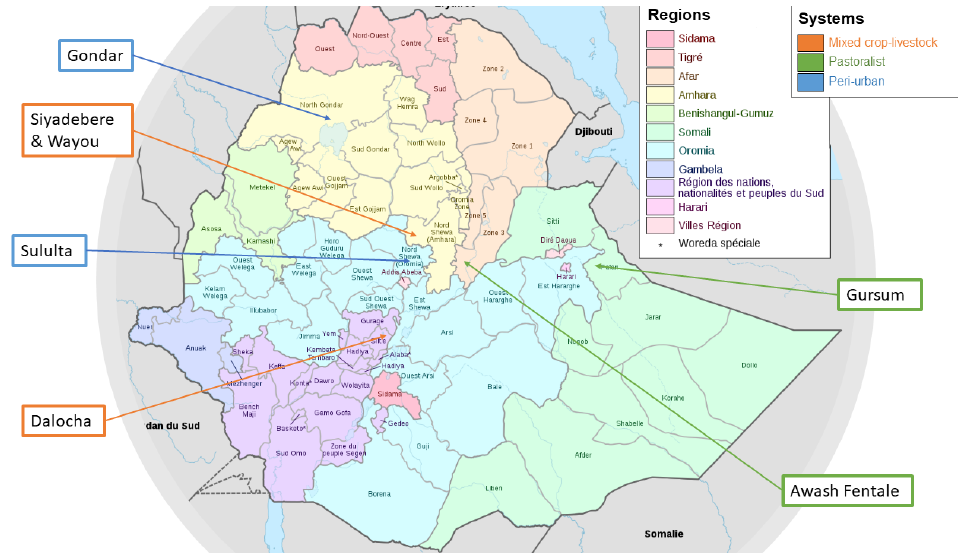
Figure 1. Map of Ethiopia with study sites labelled. Map by Bouzinc, 2020—Own work, CC BY-SA 4.0, https://commons.wikimedia.org/w/index.php?curid=95981571 (accessed on 10 August 2021).